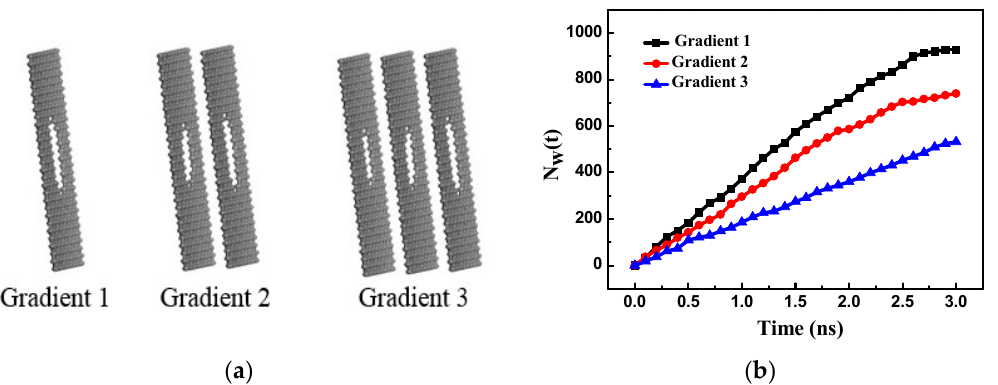
Figure 12. ( a ) Gradient 1, Gradient 2, and Gradient 3 porous graphene membranes; ( b ) the number of